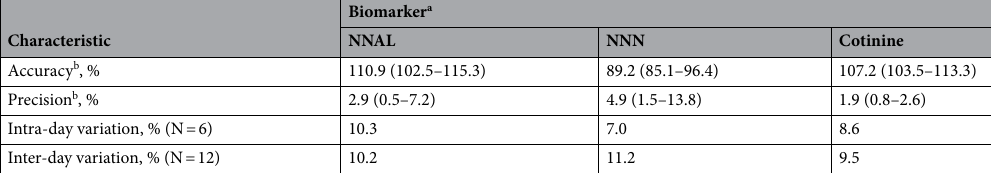
Table 1. Method characteristics for simultaneous analysis of urinary total NNAL, NNN and cotinine. a Biomarker abbreviations: NNAL, 4-(methylnitrosamino)-1-(3-pyridyl)-1-butanol; NNN, N ′ - nitrosonornicotine. b Accuracy and precision were determined in pooled urine from non-users of tobacco to which biomarkers were added in the ranges from 0.1 to 23.9 pmol/mL for NNAL, 0.1 to 5.6 pmol/mL for NNN, and 0.6 to 84.7 nmol/mL for cotinine. The numbers shown are accuracy and precision averages for all levels of addition and minimum–maximum ranges (in parentheses). For more detail on method characterization see “Methods” section.